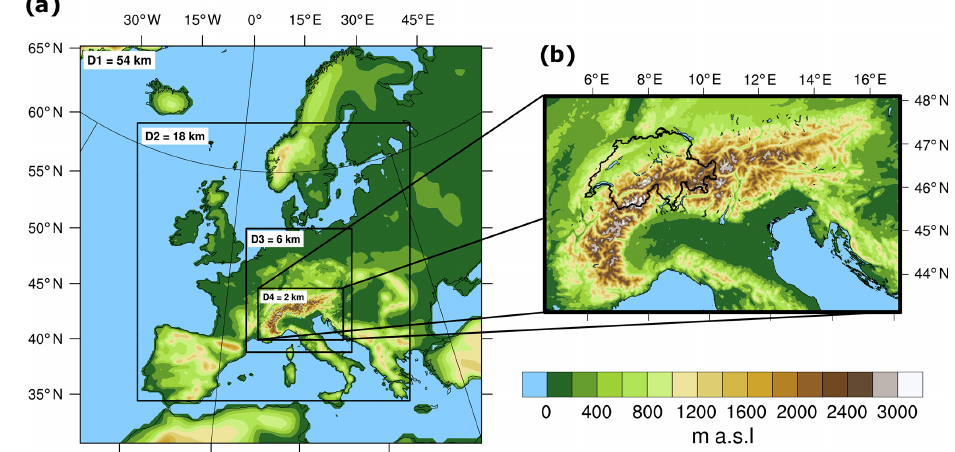
Figure 1. WRF domains and present-day topography. Panel (a) illustrates the present-day topography and the four domains used by WRF. Panel (b) shows the fourth domain including the area of interest (Switzerland) outlined by a black line. Table 2. Important parameterisations used to run WRF. Parameterisation Parameter name Chosen parameterisation Applied to Microphysics mp_physics WRF single-moment six-class scheme Longwave radiation RRTM scheme Dudhia